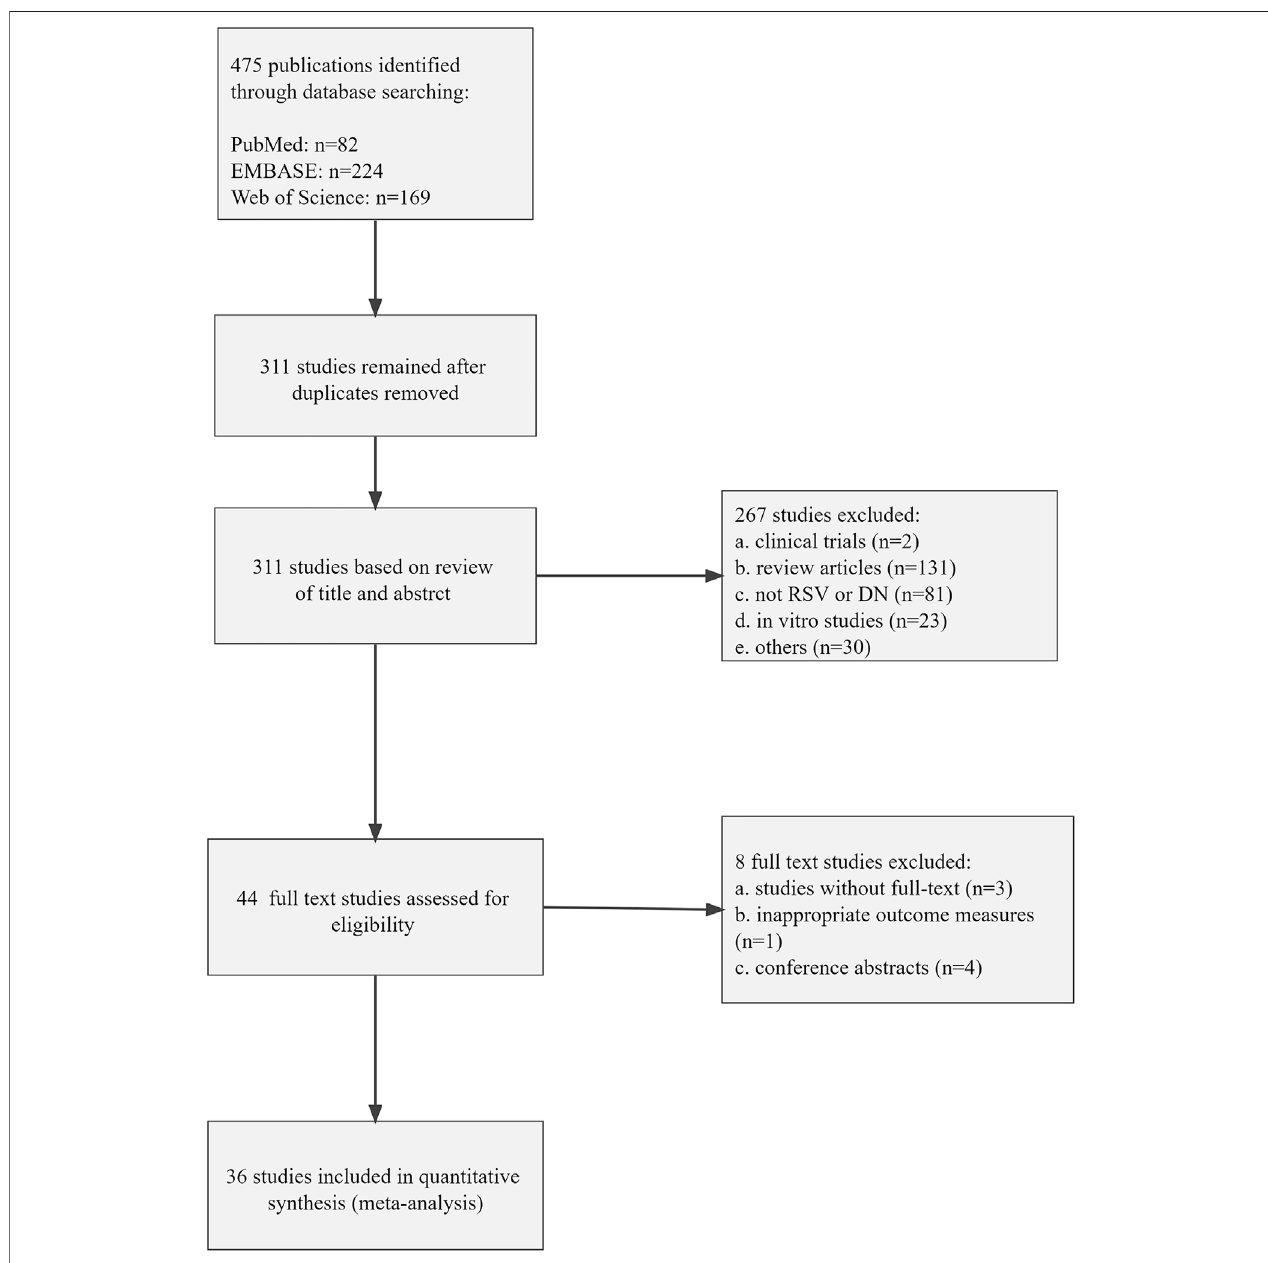
FIGURE 1 | Flow diagram of the study selection process for this